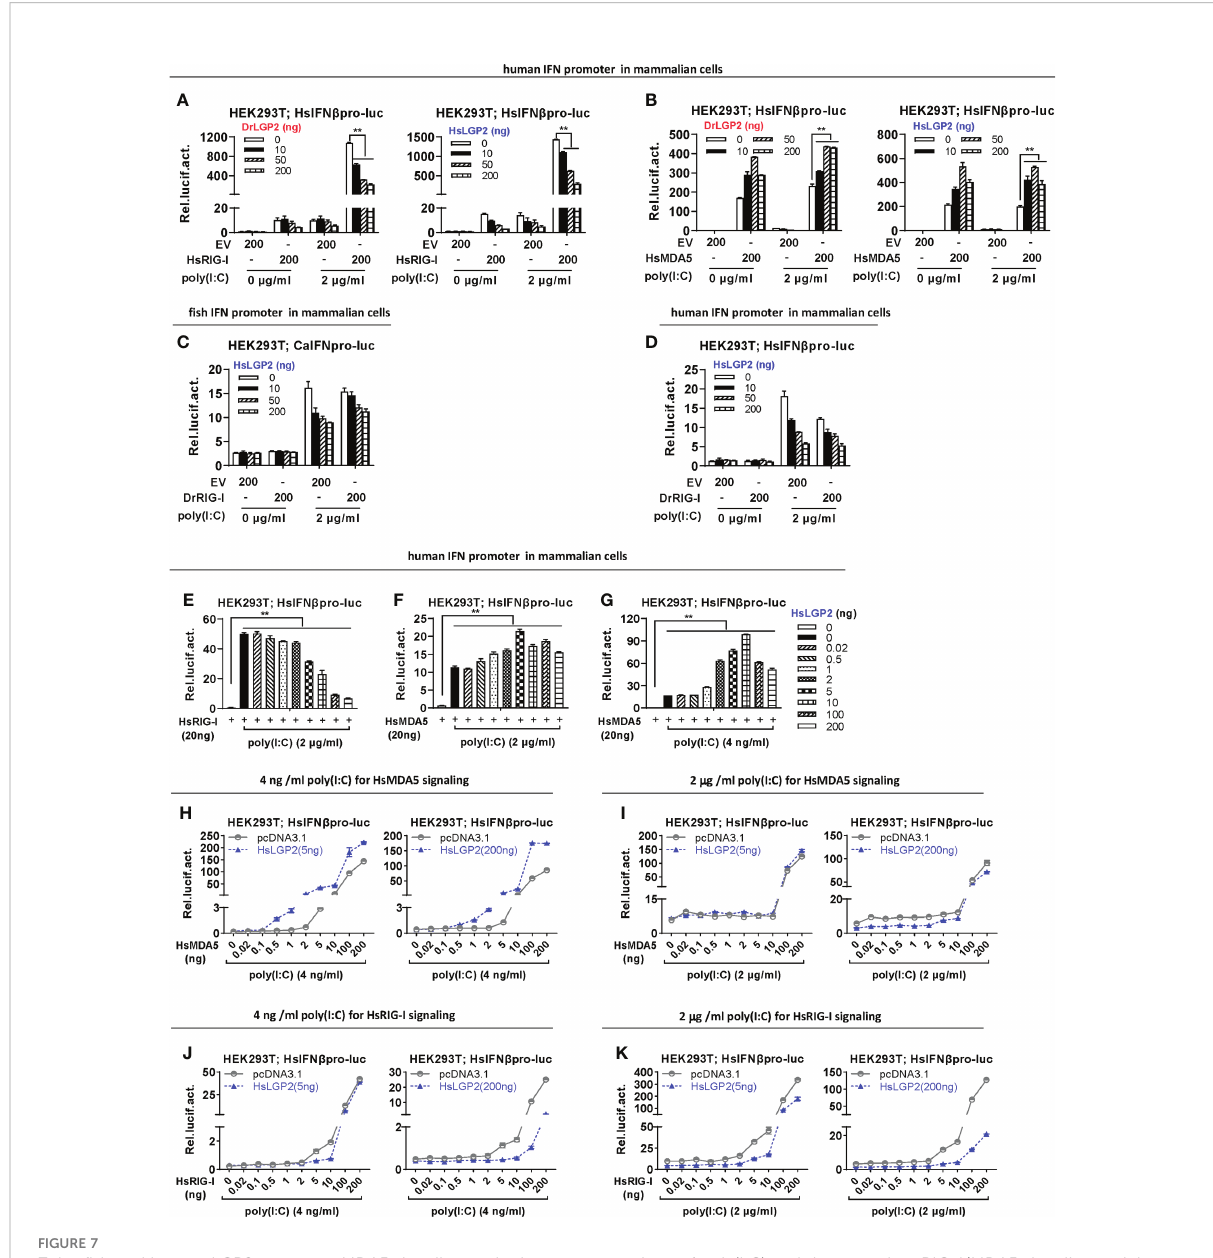
FIGURE 7 Zebra fi sh and human LGP2s promote MDA5 signaling under low concentrations of poly(I:C) and downregulate RIG-I/MDA5 signaling mainly under high concentrations of poly(I:C) in mammalian cells (A, B) DrLGP2 and HsLGP2 promoted human IFN b activation by HsMDA5 at a high dose and downregulated IFN response by HsRIG-I at a high dose in mammalian cells. HEK293T cells seeded in 24-wells plates were transfected with HsIFN b pro-luc, DrLGP2 or HsLGP2 at increasing doses, together with HsRIG-I (A) or HsMAD5 (B) (200 ng each). 24 h later, cells were transfected again with or without poly(I:C) (2 m g/ml) for another 24 h, followed by luciferase assays. P values were calculated using ANOVA. ** P <0.01. (C, D) HsLGP2 negatively regulated zebra fi sh RIG-I signaling in mammalian cells. HEK293T cells seeded in 24-wells plates were transfected as in A with the indicated plasmids. (E – G) Titration of HsLGP2 expression revealed differential regulation of RIG-I- and MDA5- triggered IFN signaling by HsLGP2 in the presence of poly(I:C) in mammalian cells. HEK293T cells seeded in 24-wells plates were transfected with HsIFN b pro-luc, HsLGP2 at increasing doses, together with HsRIG-I (E) or HsMAD5 (F, G) (200 ng each). 24 h later, cells were transfected with or without poly (I:C) at 2 m g/ml (E, F) or at 4 ng/ml (G) for another 24 h, followed by luciferase assays. P values were calculated using ANOVA. ** P <0.01. (H – K) Titration of HsMDA5/MsRIG-I showed that HsLGP2 promoted HsMDA5 signaling under low concentrations of poly (I:C) and downregulate HsRIG-I signaling mainly under high concentrations of poly (I:C) in mammalian cells. HEK293T cells seeded in 24-wells plates were transfected with HsIFN b pro-luc, HsLGP2, together with increasing doses of HsMDA5 (H, K) or HsRIG-I (J, K) . 24 h later, cells were transfected with or without poly (I:C) at 4 ng/ml (H, J) or 2 m g/ml (I K) for another 24 h, followed by luciferase